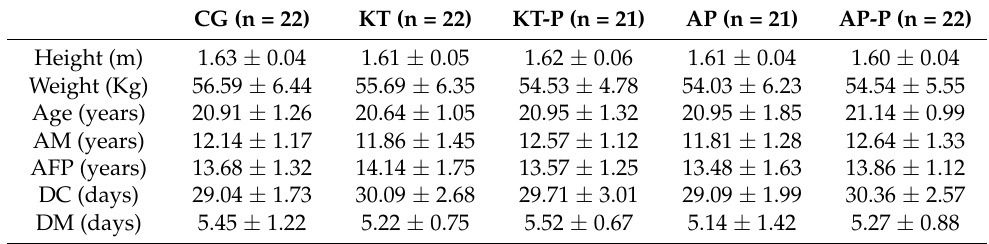
Table 1. Epidemiological data and secondary outcome